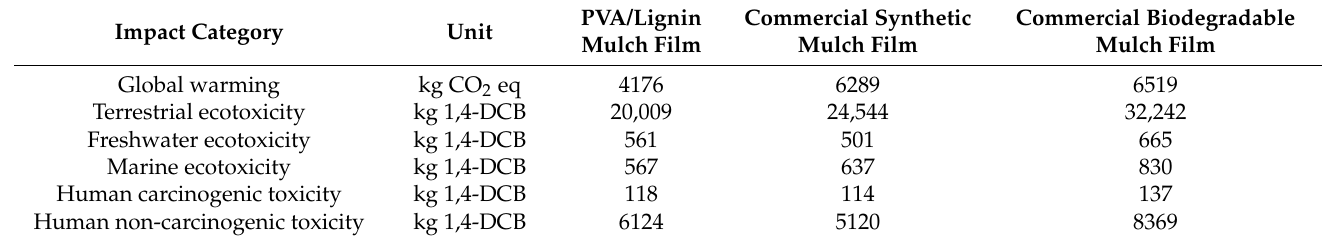
Table 5. Characterization of mulch film PVA with lignin (20PVA/80LN) compared with PVA mulch film, commercial synthetic, and biodegradable mulch films using ReCipe Midpoint (H).